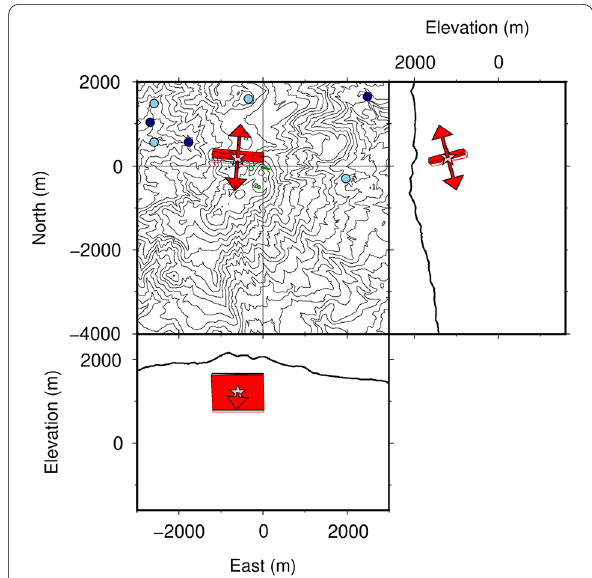
Fig. 12 Location and geometry of the tensile crack for candidate ( d1 ). The red arrows indicate the opening direction. The stars represent the centroid of candidate ( d1 )